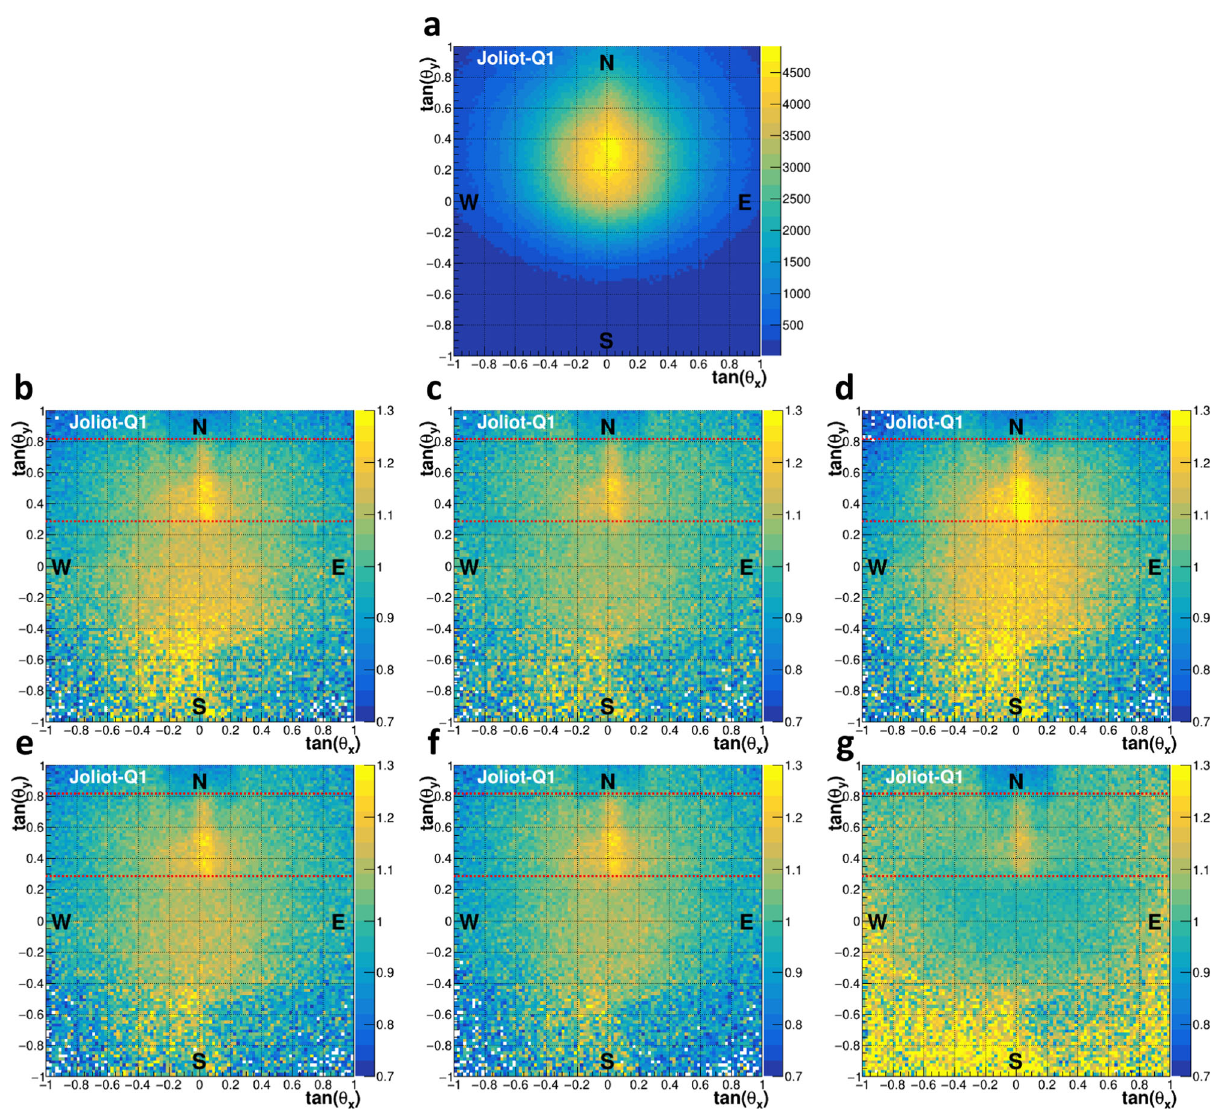
Fig. 6 | Effect of the muon parametrization on the comparison between data and simulation. a Muography of the Joliot instrument. b – g Ratio between Joliot muography and Geant4 simulations of the known structures, using